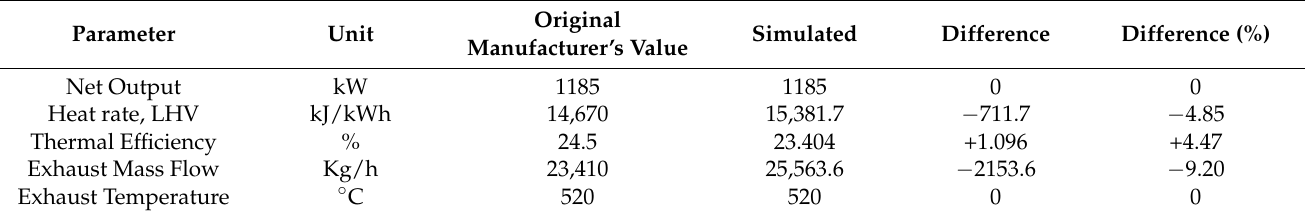
Table 4. Saturn 20 Design Point Performance Comparison—simulated and original manufacturer’s